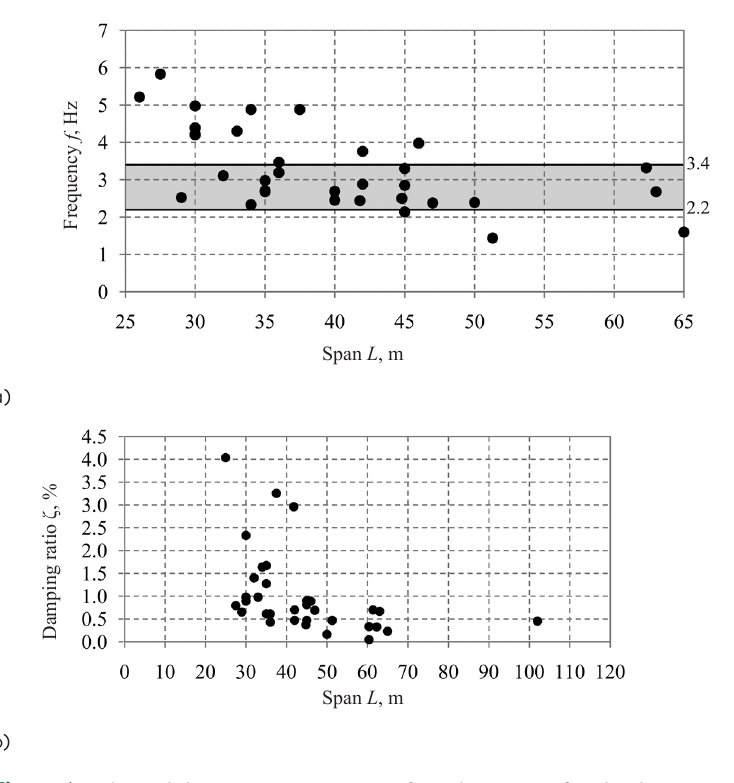
Figure 1. Selected dynamic parameters of medium span footbridges a) fundamental natural vertical vibration frequencies (shaded area – the range of frequency of steps during running), b) damping ratio in steel